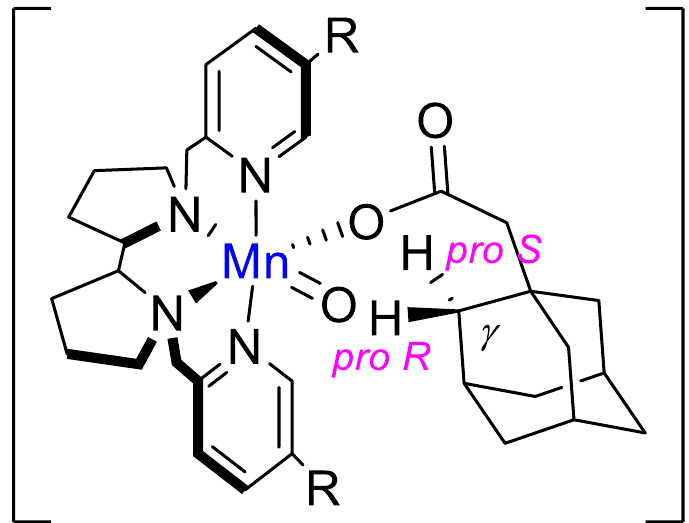
Figure 4. Directing effect of the carboxylic group in the substrate.